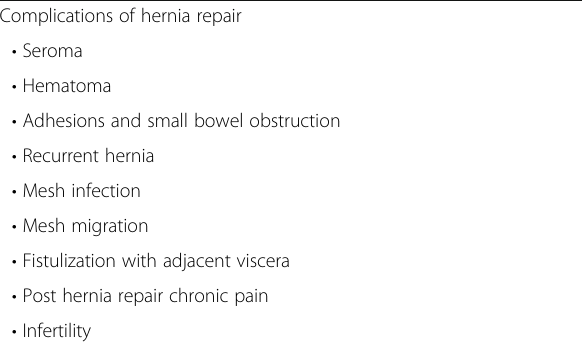
Table 1 Complications of hernia repair Complications of hernia repair